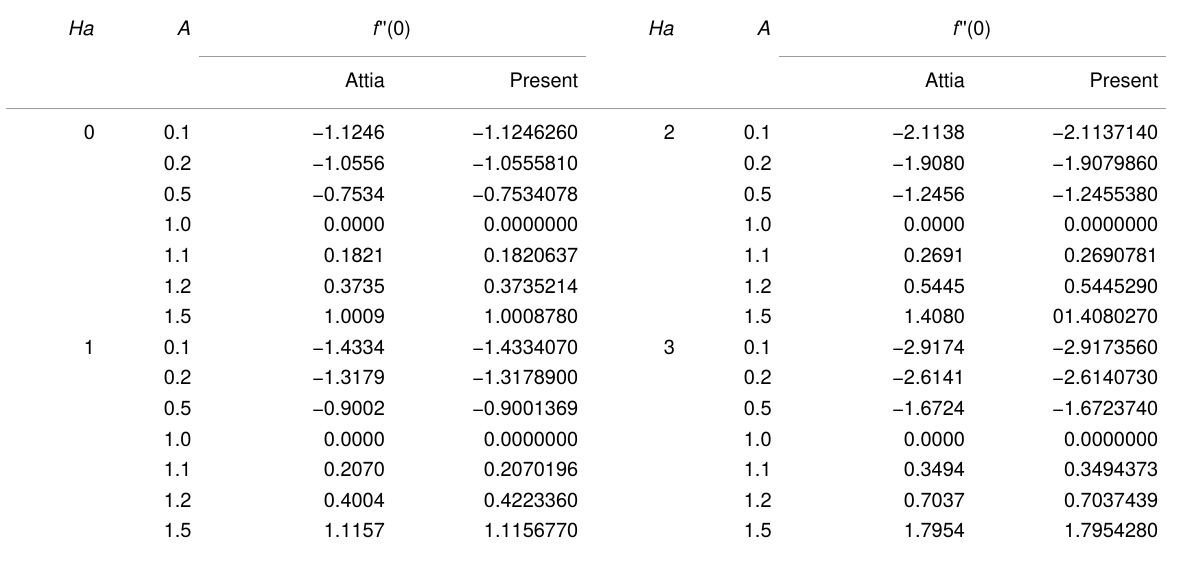
Table 1: Comparison between the computed values of f ''(0) and the values given by Attia [37], when Nt = Nb = R = Ec = Sc = 0. Ha A